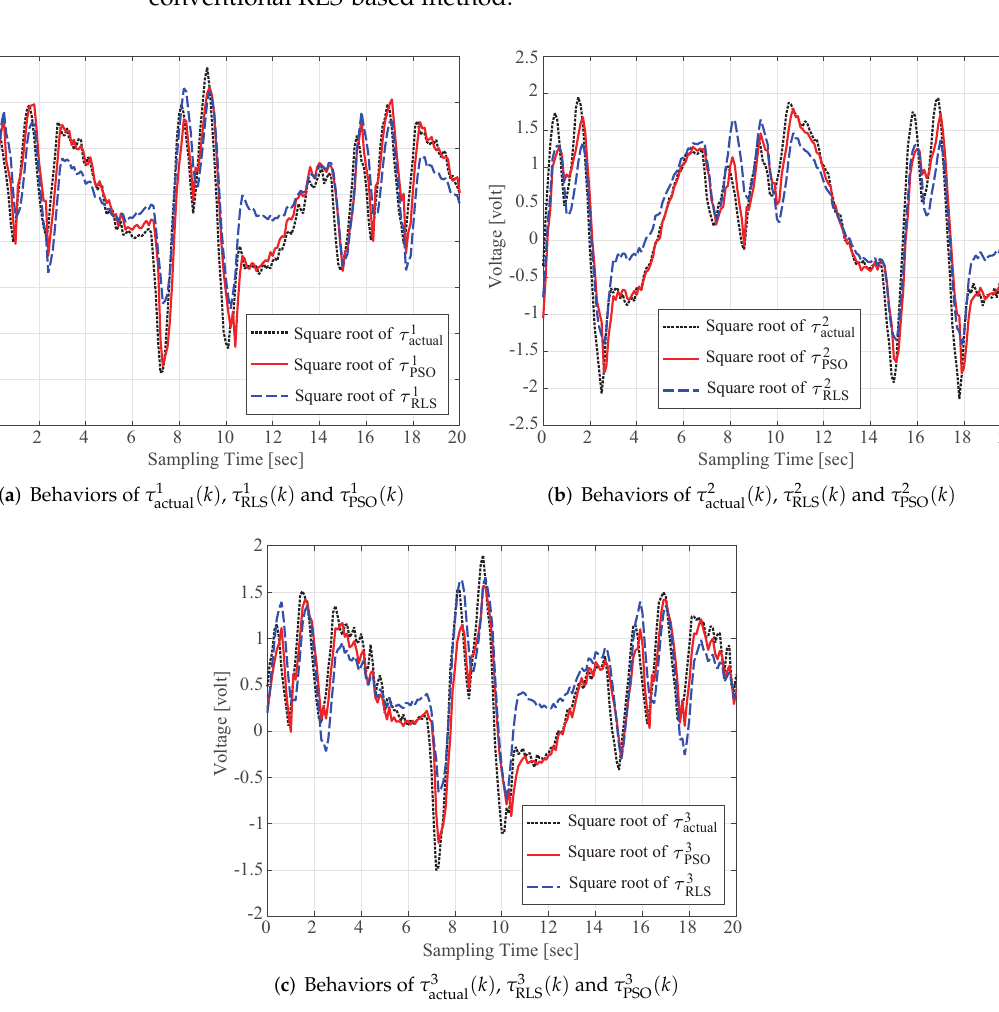
( k ) obtained from RLS- RLS